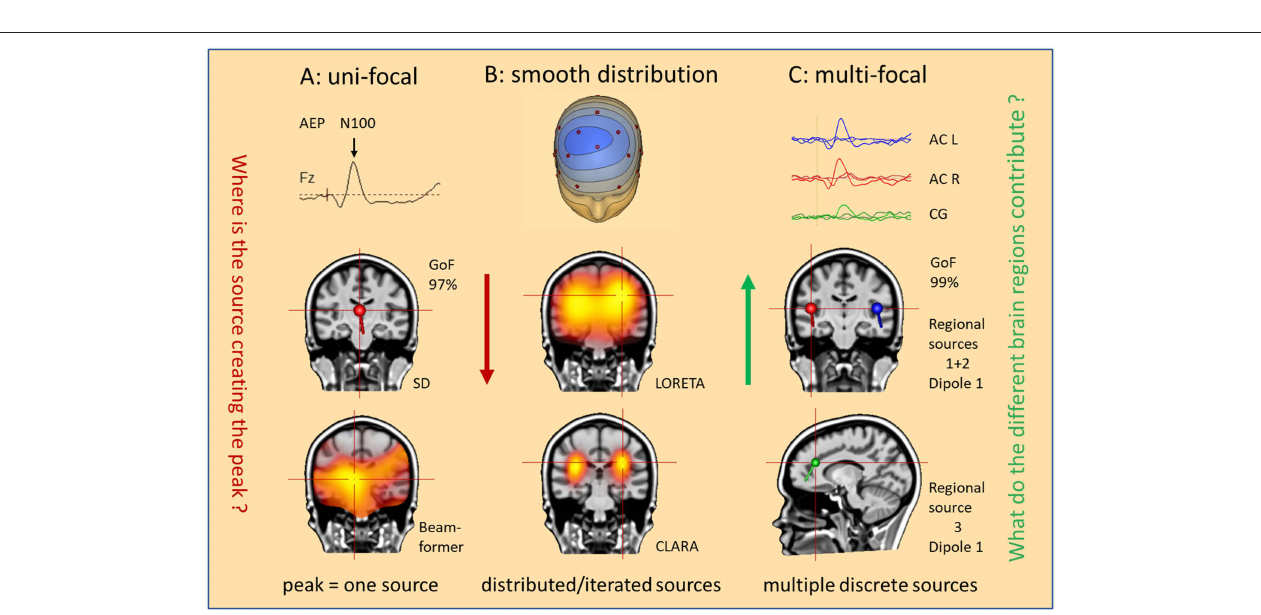
FIGURE 2 | What is our hypothesis? Three hypotheses are illustrated as mental starting points to understand the origin of the N100 peak of the LAEP. (A) Uni-focal: a single dipole (SD) or beamformer will localize to an equivalent center in the middle of the brain. (B) Smooth distribution: activity appears widely distributed in the Brain (LORETA); separate foci can be better isolated by iteration of the smeared images (CLARA). (C) Multifocal: what do the different brain regions contribute? Multiple discrete sources (RS1–RS3) model the three regions (AC L, AC R, CG) involved in the generation of this LAEP. The answer is the source waveforms shown on top.